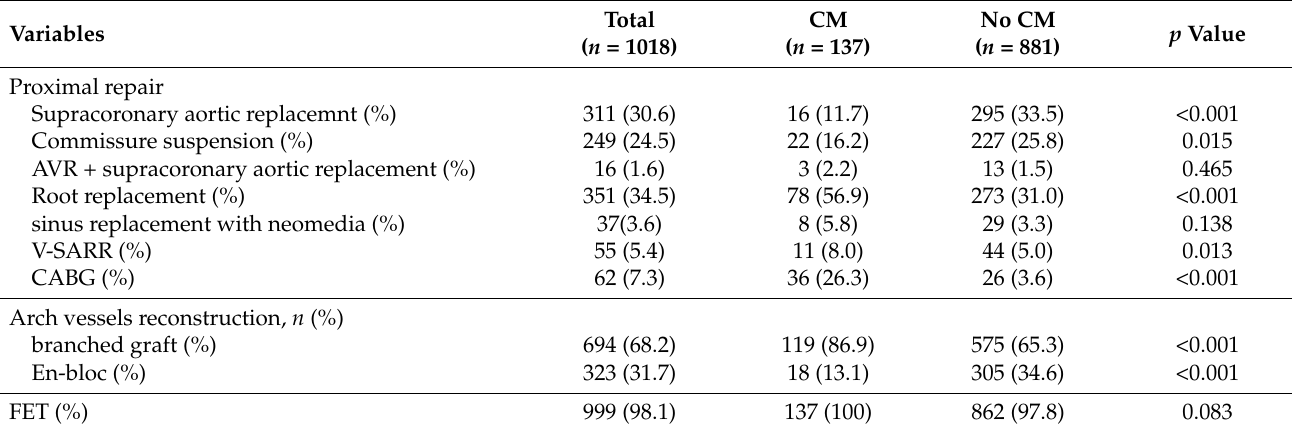
Table 2. Operative characteristics of the entire